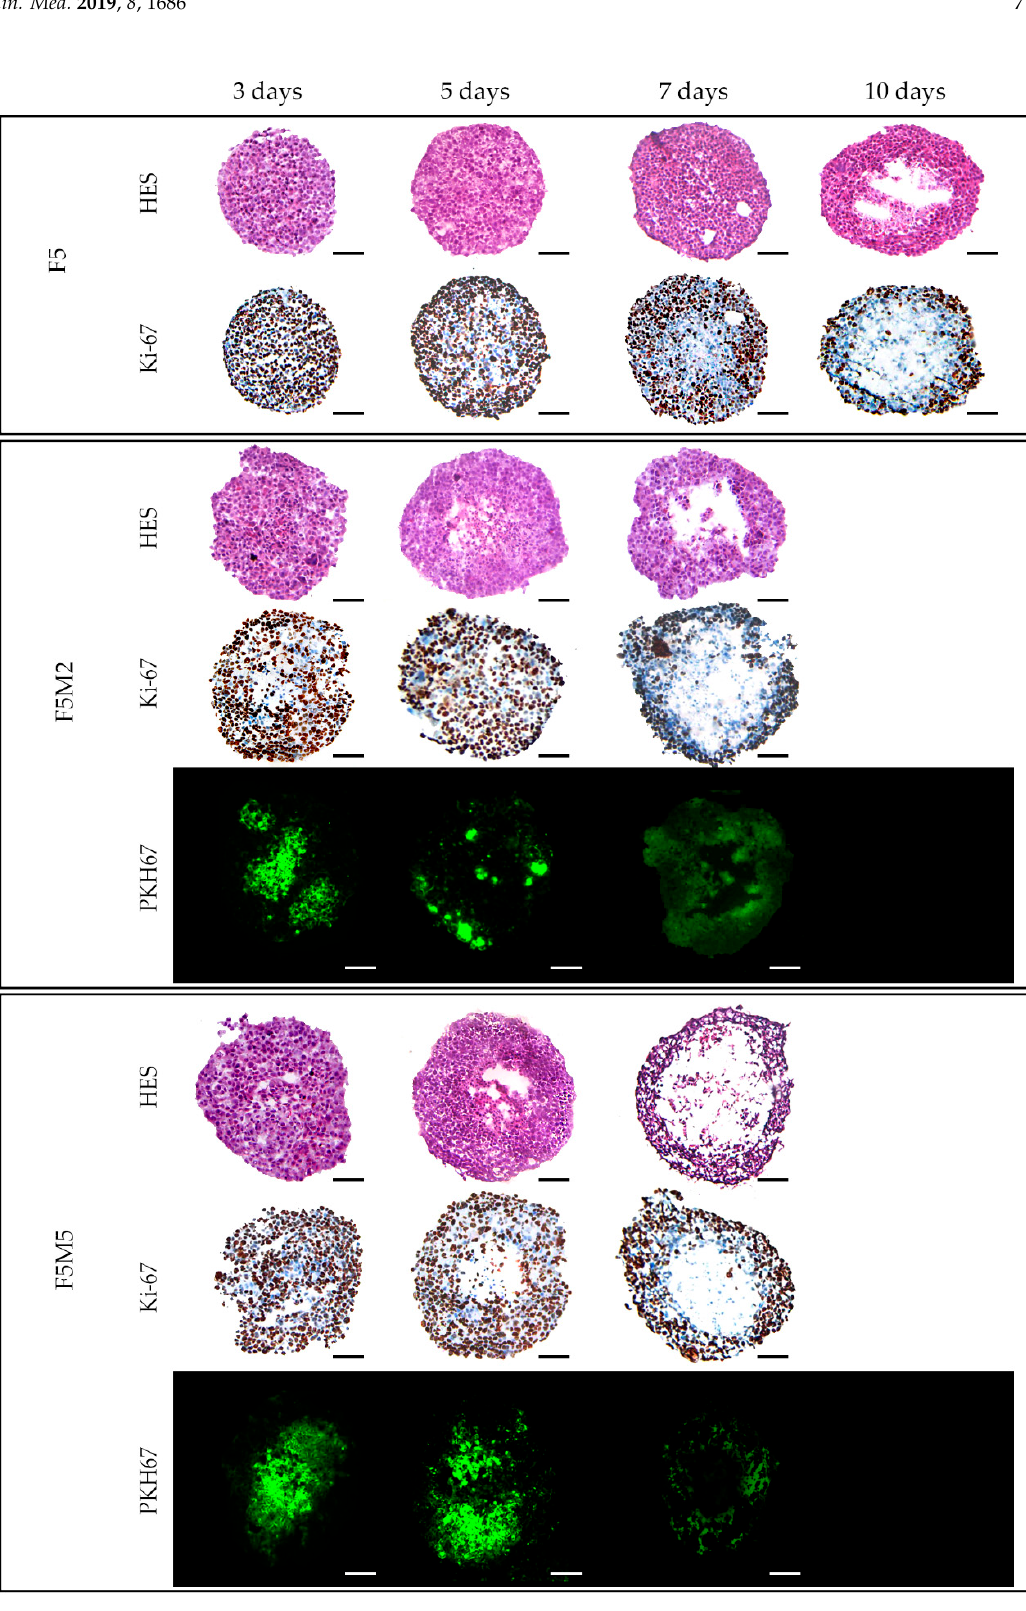
Figure 2. Typical cryosections images of FaDu monoculture (F5) and FaDu:MeWo (5:2 and 5:5) co-culture spheroids stained with HES and Ki-67 at days 3, 7 and 10 days post-seeding. MeWo cells were additionally pre-stained with PKH67 green fluorescent dye. Scale bars: 100 µm.